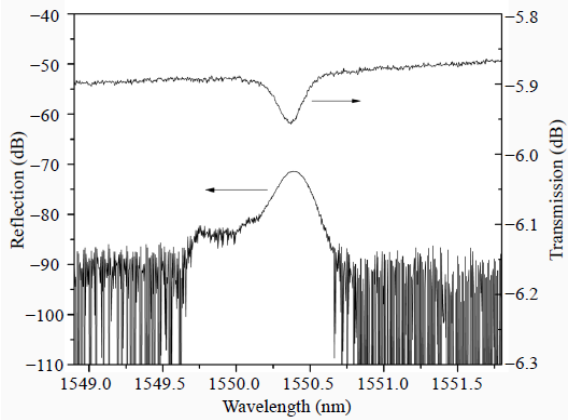
Fig. 2 Reflection and transmission spectra of the DTG